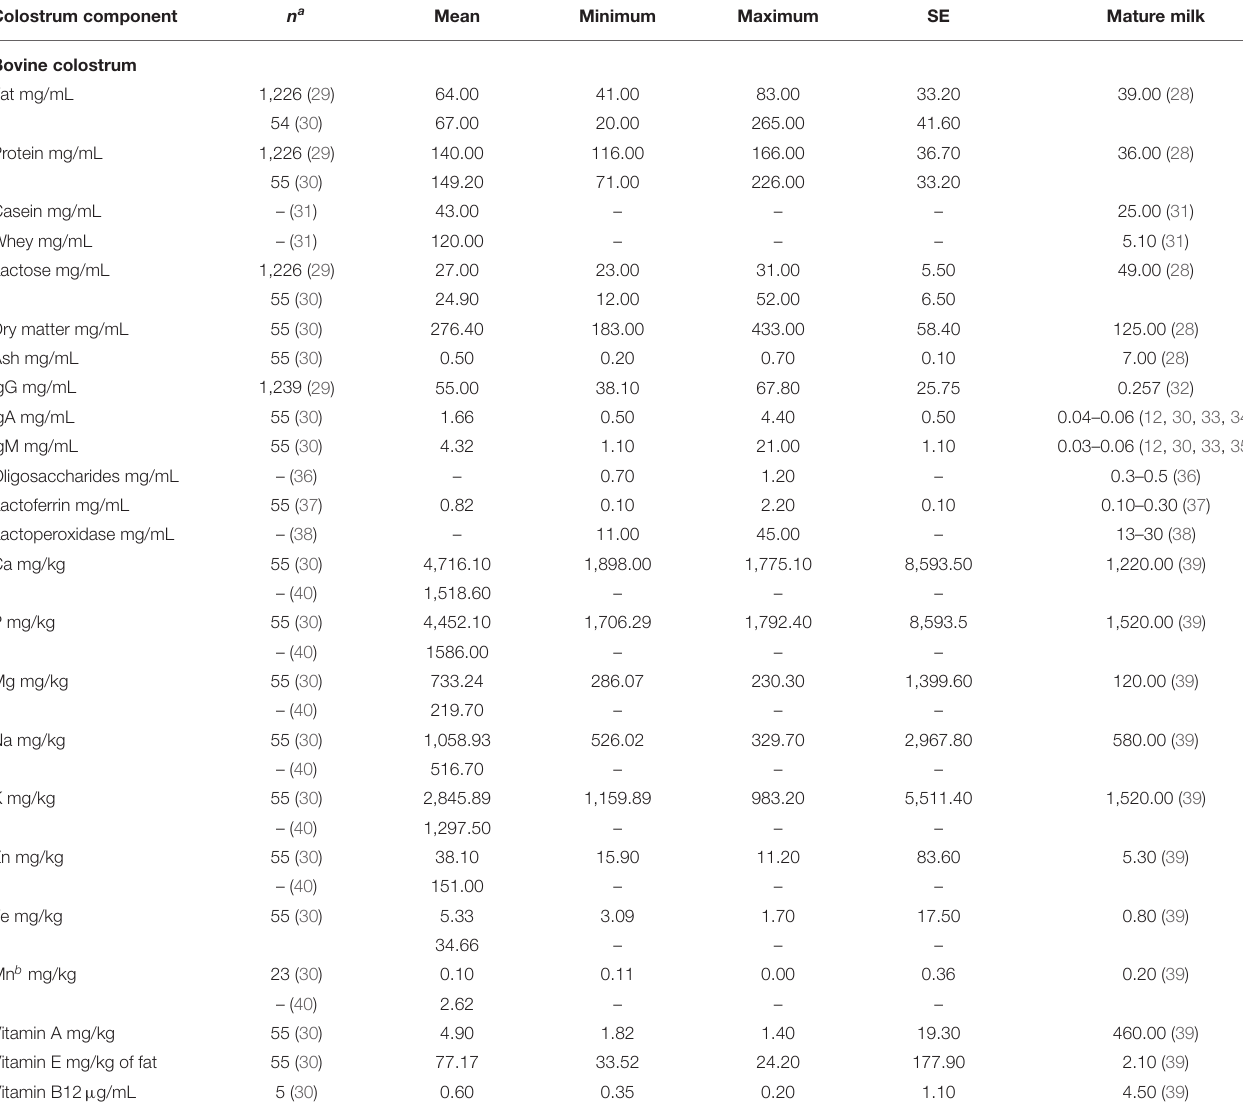
TABLE 1 | Bovine colostrum and mature milk